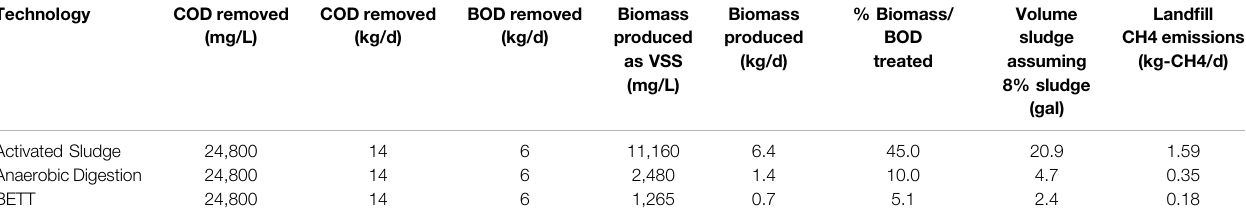
TABLE 3 | Estimation of land fi ll GHG emissions for BETT system and aerobic and anaerobic technologies processing identical BOD load. Technology